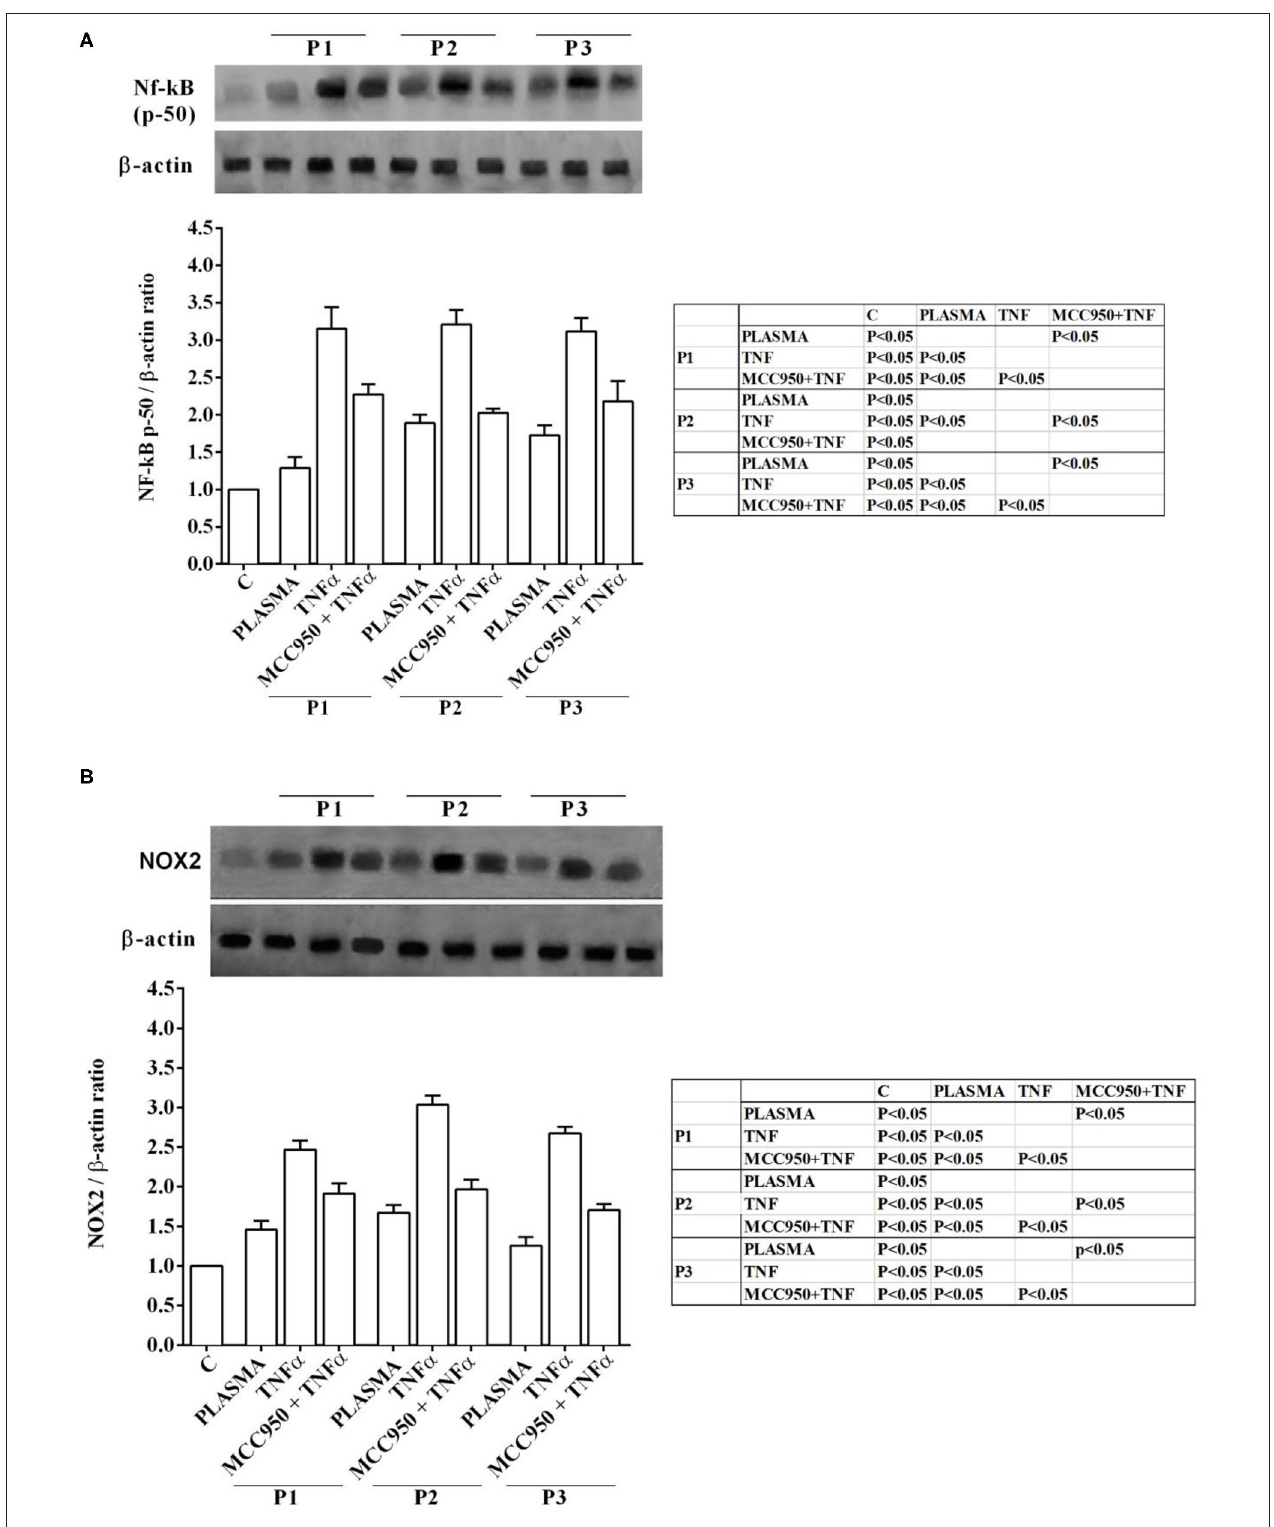
FIGURE 3 | Effects of NAFLD plasma on NF-kB (A) and NOX2 (B) expression in Huh7.5 cells. P, patient; M, MCC950 (1nM, for 30min). Other abbreviations are as described in previous Figures. In the densitometric analysis, all values are normalized vs. control which is normalized, as well, and considered as 1. They are shown as fold changes vs. control. Reported data are means ± SD of five independent experiments for each experimental protocol.